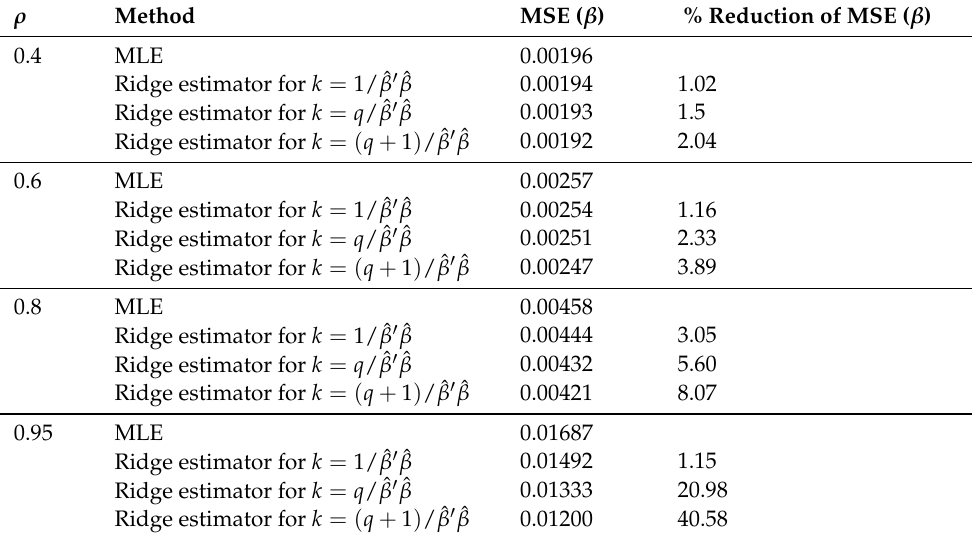
Table 3. Comparison of MSE between the MLE and ridge estimators in simulation; n =